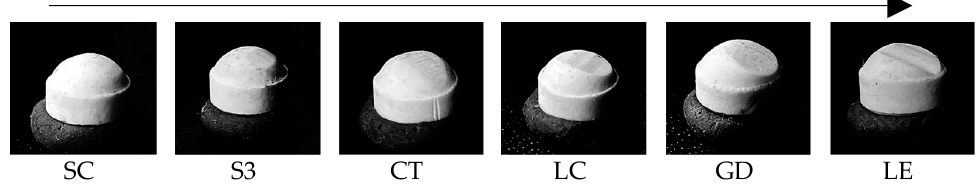
Figure 4. Increasing surface wear of the enstatite antagonists.